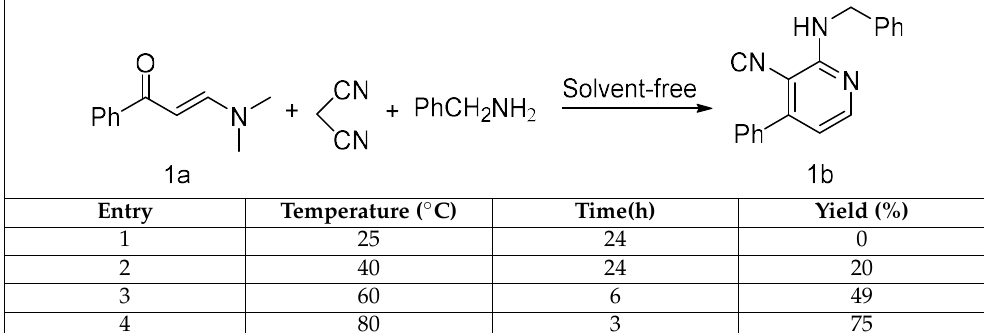
Table 2. Optimization of the reaction condition for 2b synthesis.